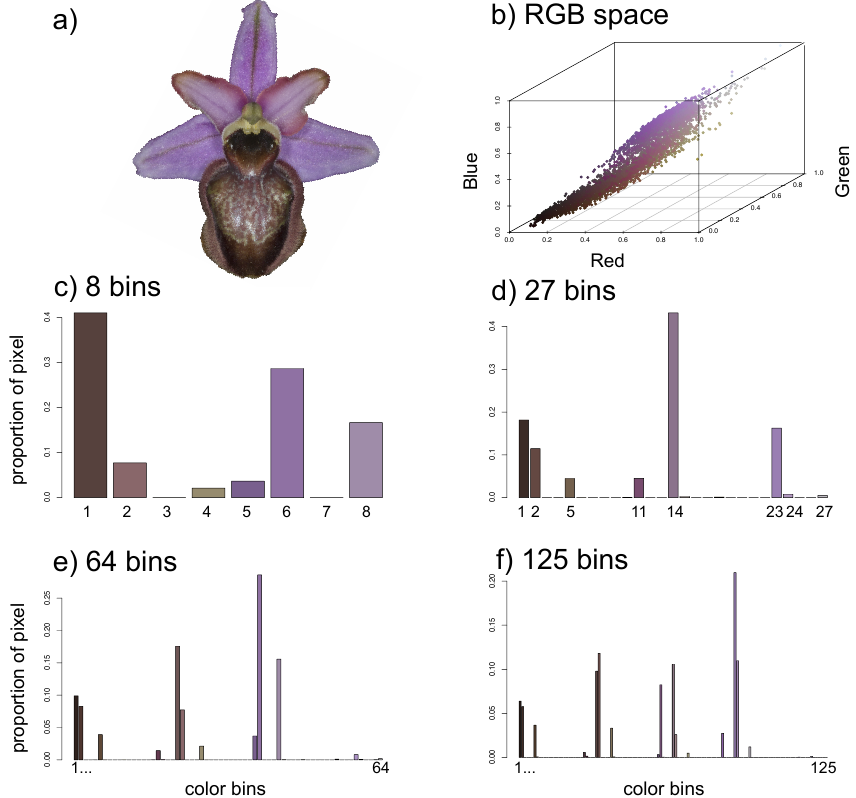
Figure 3. Colour binning for an image specimen of Ophrys aveyronensis subsp. aveyronensis . ( a ) Whole- flower image. ( b ) Scatterplot of all non-background pixels in RGB space. ( c ) Histogram showing the proportion of pixels assigned to each of eight bins, ( d ) 27 bins, ( e ) 64 bins, and ( f ) 125 bins. For plots c–f, bins are coloured by the average colours of the pixels in each bin, and X and Y axes refer to the colour bins and the proportion of pixels by image,